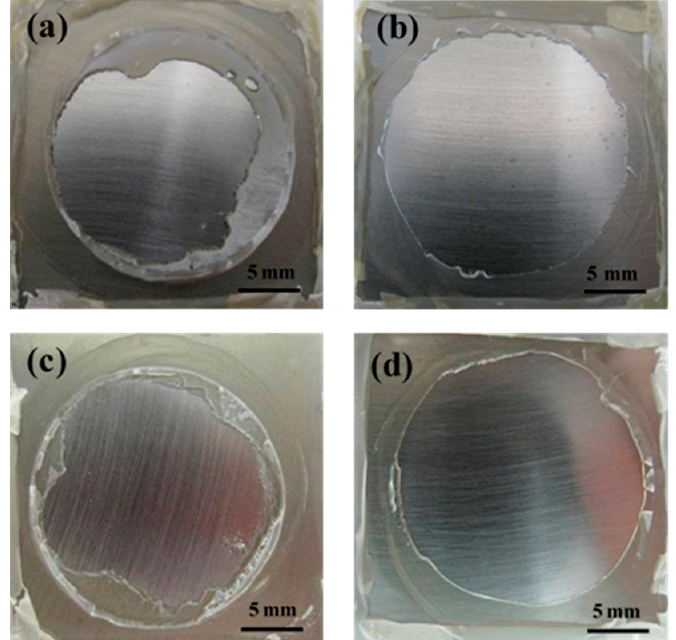
Figure 6. Macroscopic fracture morphology pictures of EGF coating/steel under two pressure conditions at different immersion times: ( a ) after immersion 48 h under ordinary pressure; ( b ) 192 h under ordinary pressure; ( c ) 48 h under hydrostatic pressure and ( d ) 192 h under hydrostatic pressure.